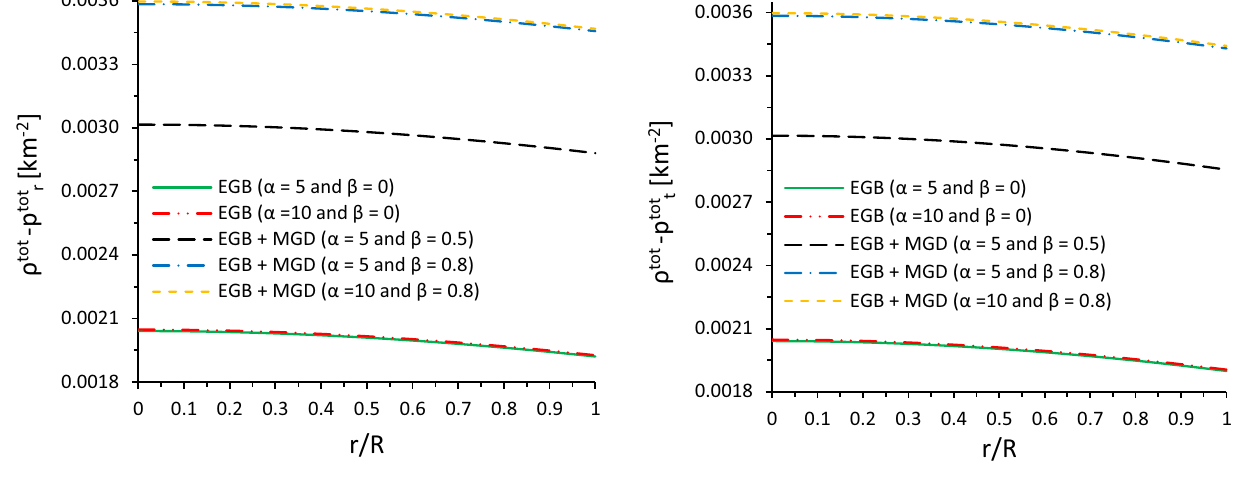
Fig. 8 The variation of dominant energy conditions versus radial coordinate r / R for solution B